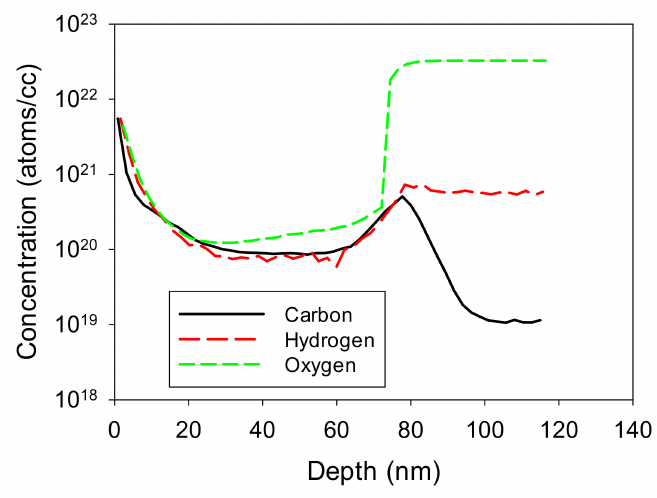
Figure 12. SIMS data for low-carbon film shown in Figure 10b. Table 3. Table showing film thickness and absorption edge data for samples grown with − 50 V bias in place. The film thicknesses data were based on UV-Vis transmission data and are only